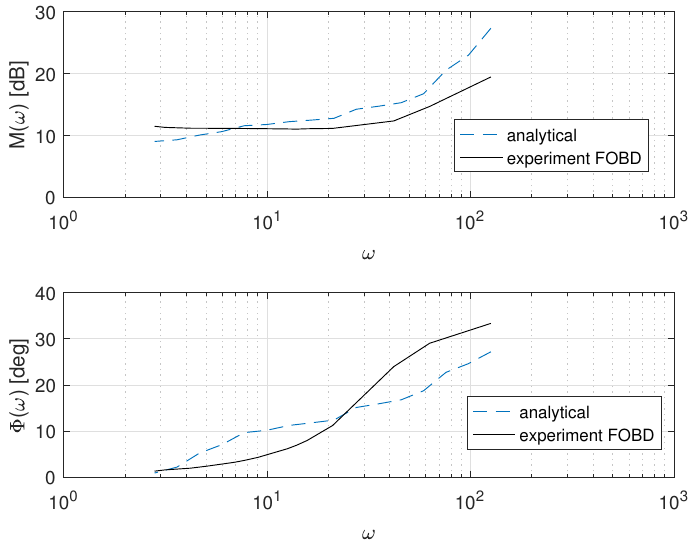
Figure 3. Comparison analytical Bode diagrams to experiments using FOBD. α = β =